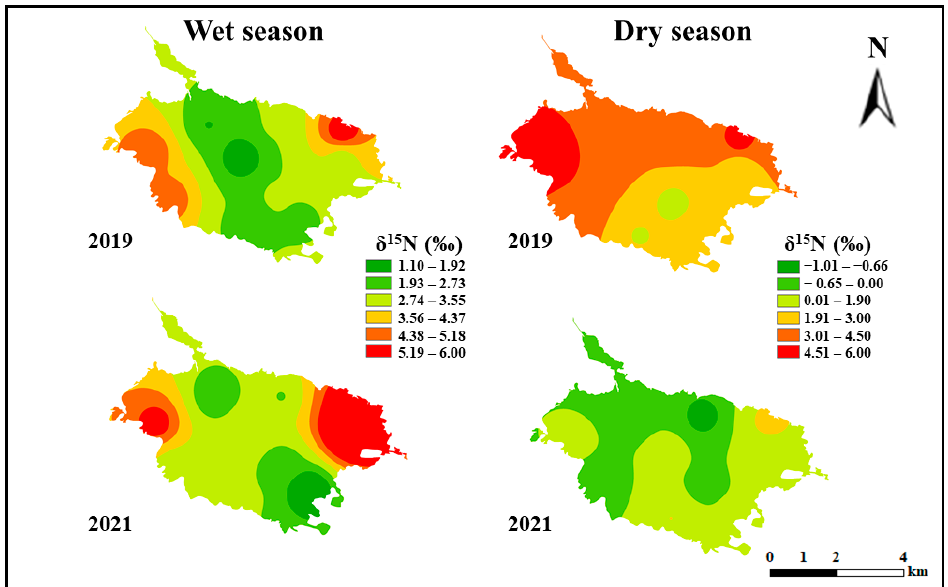
Figure 6. Temporal and spatial variation of nitrogen stable isotope in wet season and dry season of Caohai Lake.